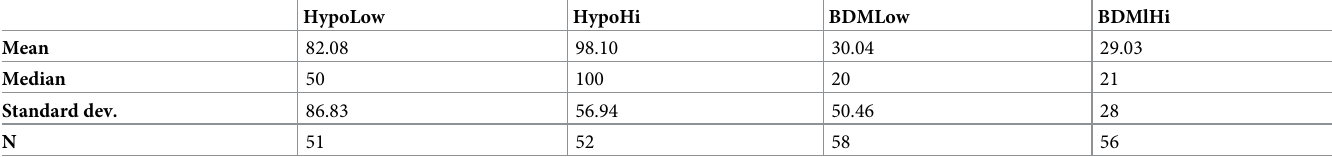
Table 2. Experiment 1: WTPs by treatment (in PLN).